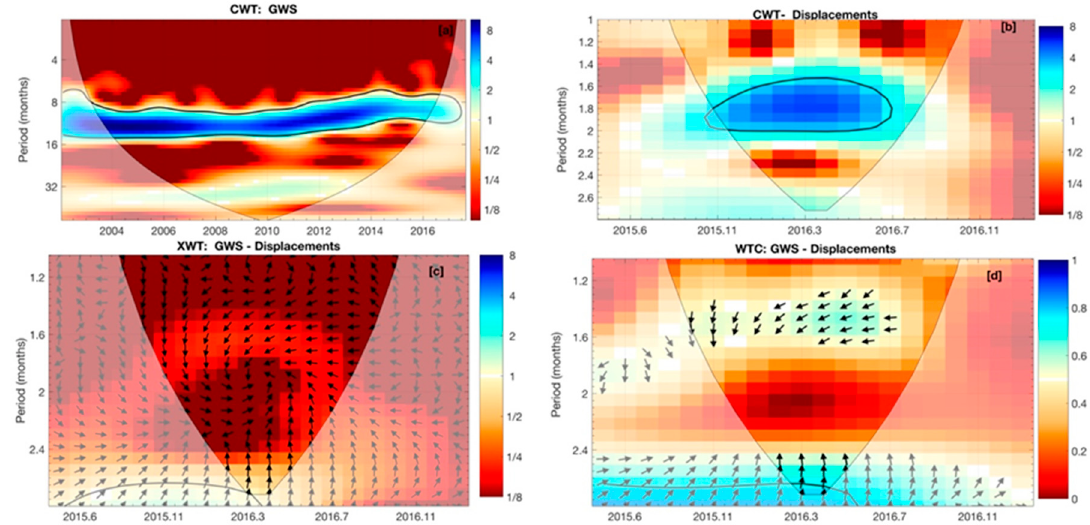
Figure 6. ( a ) Continuous wavelet transform (CWT) power of the groundwater storage (GWS) change volume time series; ( b ) CWT of displacements. ( c ) Cross-wavelet transforms (XWT) of the ∆ GWS and displacements ( d ) wavelet coherence (WTC) of ∆ GWS and displacements.